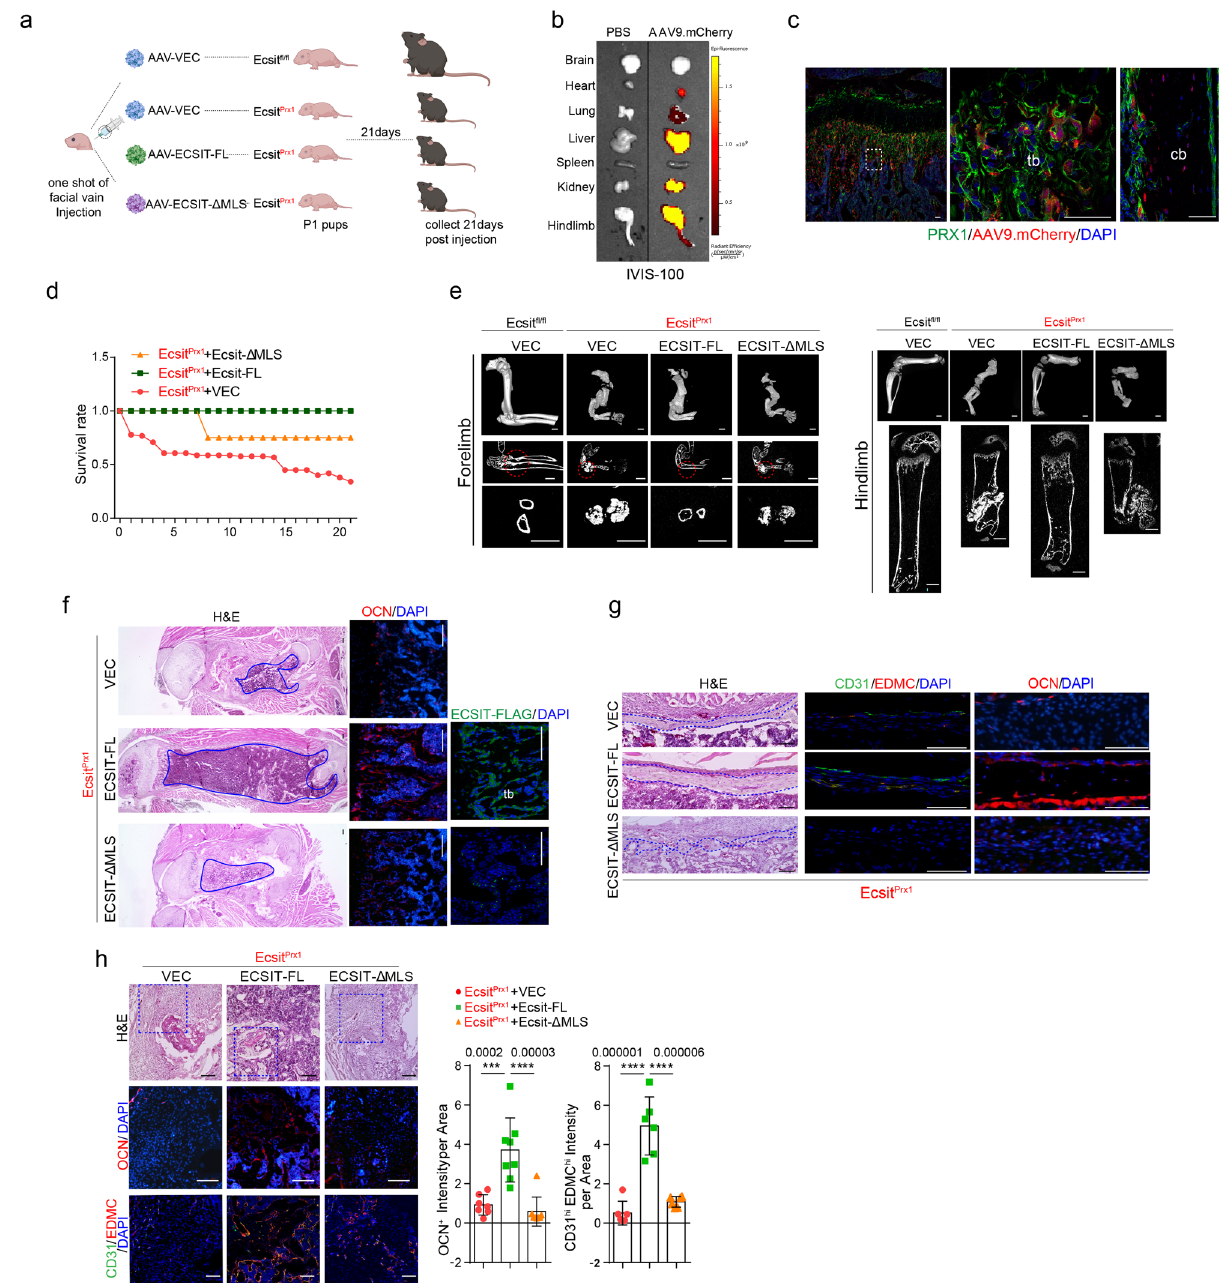
Fig. 3 | AAV-mediated expression of ECSIT reverses Ecsit Prx1 skeletal pheno- types. a Diagram summarizing the study and treatment methods. A single dose of 2x10 11 genome copies (GCs) of rAAV9 vectors carrying control vector or FLAG- ECSIT constructs was injected into P1 Ecsit Prx1 neonates via the facial vein and musculoskeletal phenotypes were assessed 21 days post-injection (created with biorender.com). b Single dose of 2x10 11 GCs of rAAV9 carrying mCherry was injected into P0 Prx1;Rosa26 mTmG neonates via facial vein and mCherry expression was monitored by IVIS-100 optical imaging 21 days post-injection. c rAAV9 vector carrying mCherry was injected into Prx1;Rosa26 mTmG neonates and 21 days later, mCherry expression was assessed by fl uorescence microscopy of cryo-sectioned femurs. d Survival rate of AAV-treated Ecsit Prx1 mice up to 21 days post-injection ( n =6). e MicroCTanalysisofthe forelimbs (left) and hindlimbs (right) of P21AAV-